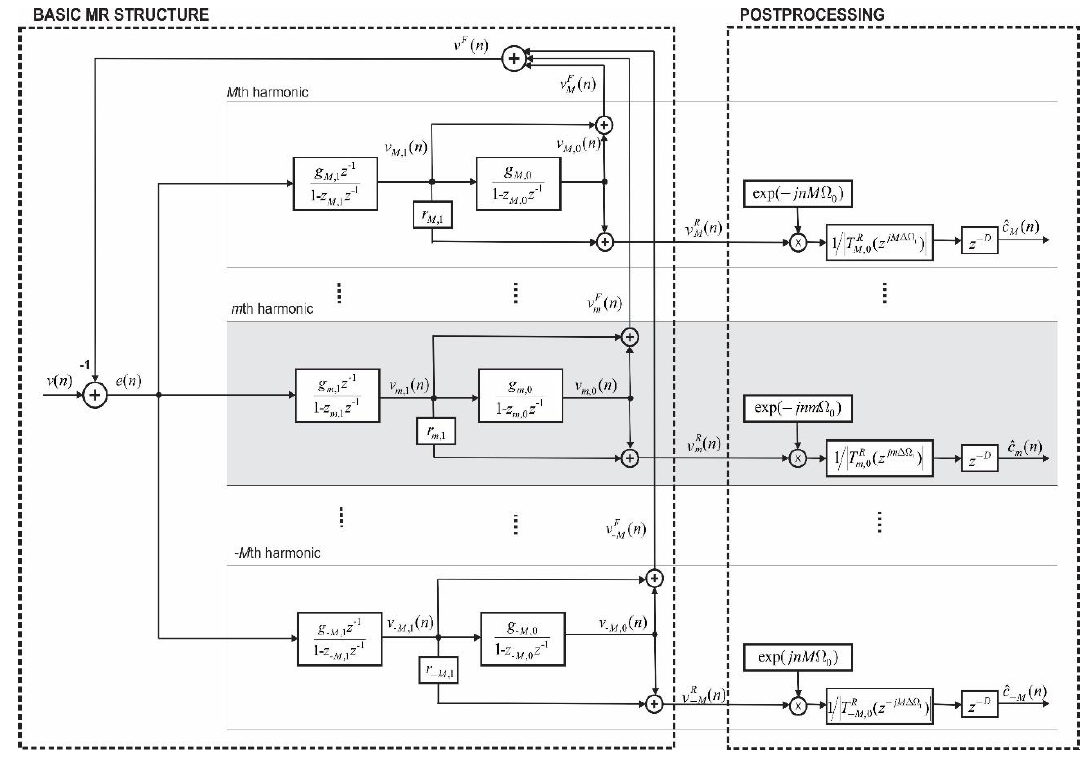
Figure 1. Structure of the second-order ( 𝐾 = 1 ) estimator.